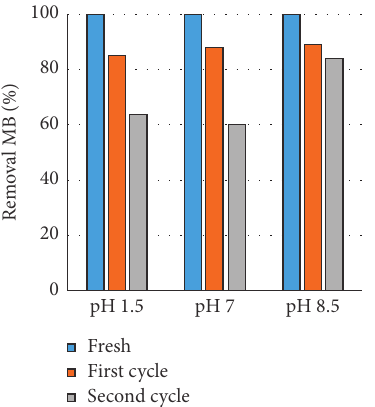
Figure 11: Removal percentage of MB from aqueous solution using MSN-Cys for the indicated adsorption/desorption